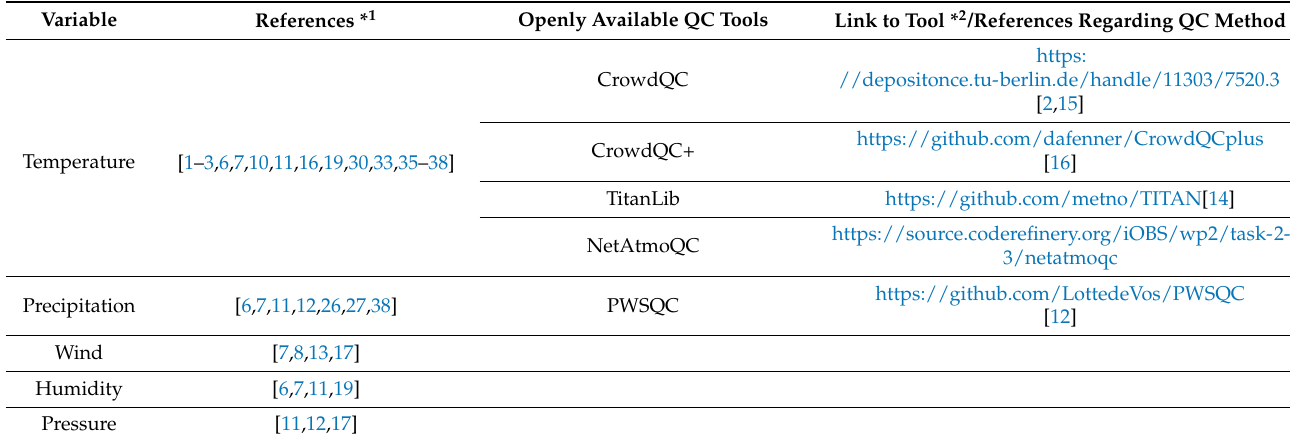
Table 1. Overview of selected references and available QC-tools for PWS